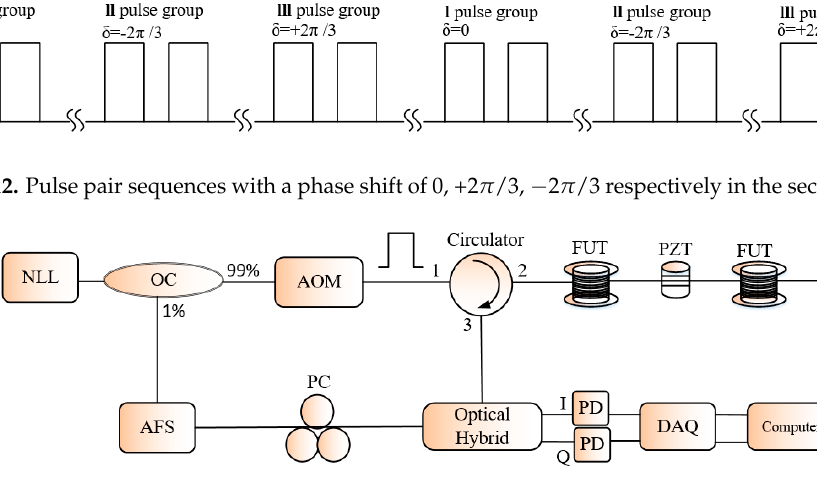
Figure 13. Setup of the Φ‐ OTDR based sensor using the 90 ° optical hybrid for phase demodulation. AFS: acoustic frequency shifter.